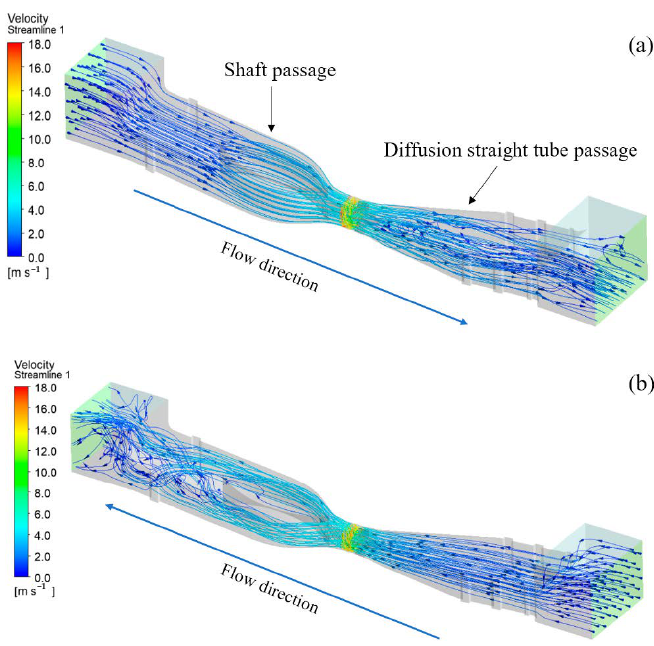
Figure 10. Streamline distributions at flow rate Q = 250.85 L/s in: ( a ) forward operation; ( b ) reverse operation.